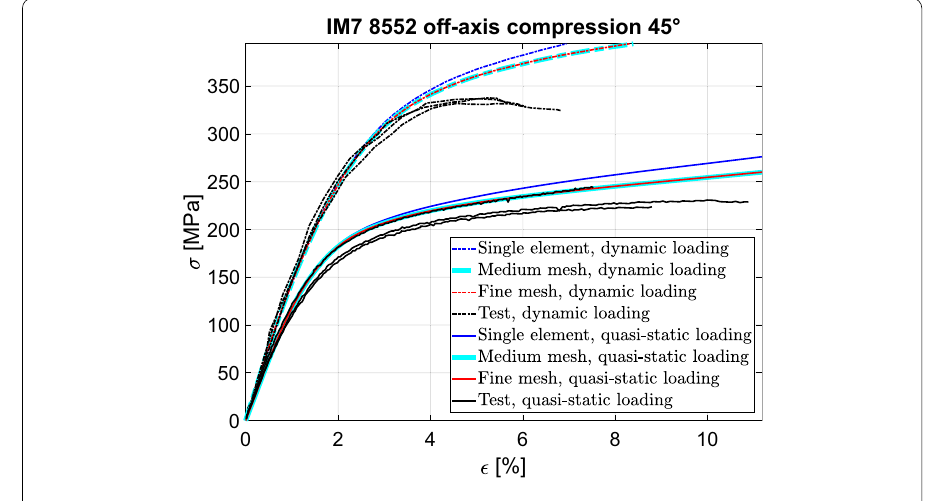
Fig. 10 Comparison of the axial stress/strain prediction using different meshes during dynamic and quasi-static simulations